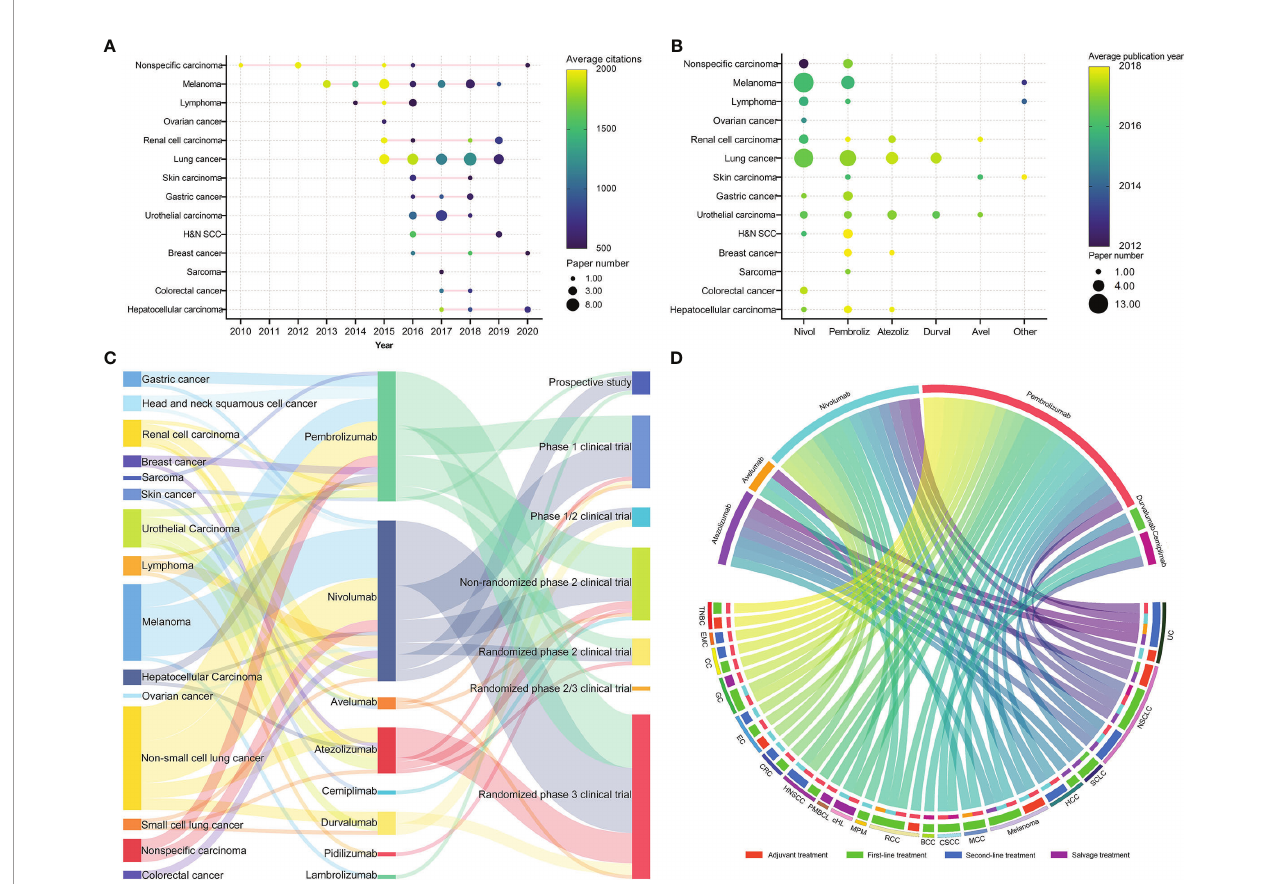
FIGURE 4 | (A) Distribution of publication time and citations of papers on cancers. The node size represents the number of publications; the color represents the average citations of the papers. (B) The relationship between cancers and anti-programmed cell death 1/programmed cell death 1 ligand 1 (anti-PD1/PDL1) antibodies. The node size represents the number of publications; the color represents the average year of publication. Atezoliz, atezolizumab; Avel, avelumab; Durval, durvalumab; H&N SCC, head and neck squamous cell cancer; Nivol, nivolumab; Other, lambrolizumab, cemiplimab, or pidilizumab; Pembroliz, pembrolizumab. (C) The relationship between cancers, anti-PD1/PDL1 antibodies, and research types for the 100 most cited papers. (D) Chordal graph of approved indications of anti-PD1/PDL1 antibodies. BCC, basal cell cancer; CC, cervical cancer; cHL, classical Hodgkin lymphoma; CRC, colorectal cancer; CSCC, cutaneous squamous cell cancer; EC, esophageal cancer; EMC, endometrial cancer; GC, gastric cancer; HCC, hepatocellular cancer; HNSCC, head and neck squamous cell cancer; MCC, Merkel cell cancer; MPM, malignant pleural mesothelioma; NSCLC, non-small cell lung cancer; PMBCL, primary mediastinal large B-cell lymphoma; RCC, renal cell cancer; SCLC, small-cell lung cancer; TNBC, triple-negative breast cancer; UC, urothelial